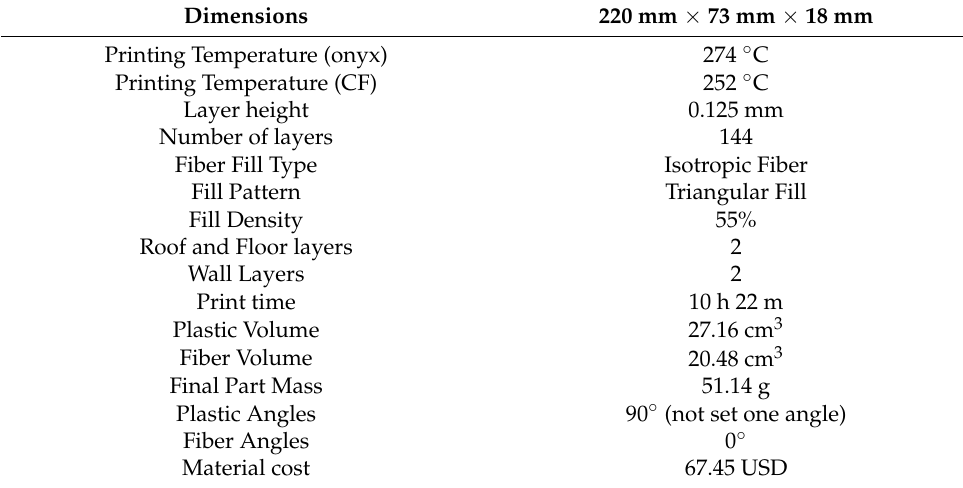
Table 2. 3D printing parameters of CF/onyx